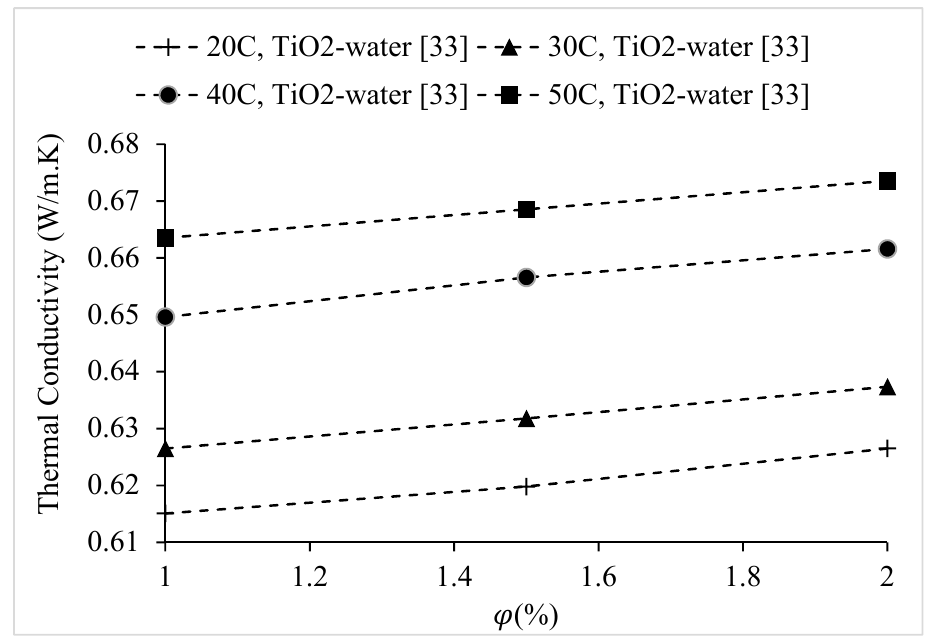
Figure 21. Variation of the thermal conductivity of TiO 2 –water nanofluid at various temperatures, as a function of nanoparticle volume concentration, 𝜑. Appl. Sci. 2018 , 8 , x FOR PEER REVIEW 29 of 56